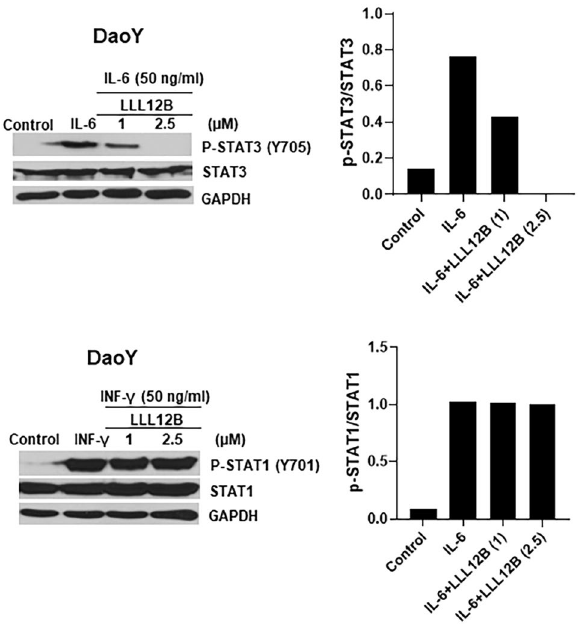
Figure 4. Inhibitory effect of LLL12B on IL-6 stimulated P-STAT3 and INF-γ induced P-STAT1 in DaoY medulloblastoma cells. DaoY cells were seeded and allowed to adhere overnight, and then the medium was changed to DMEM with 0% FBS. Cells were treated with LLL12B or DMSO for 4 h, and then 50 ng/ml of IL-6 or INF-γ was added for 30 min and cells were harvested for Western blot. For the control group, cells were treated only with DMSO and neither IL-6 nor INF-γ was